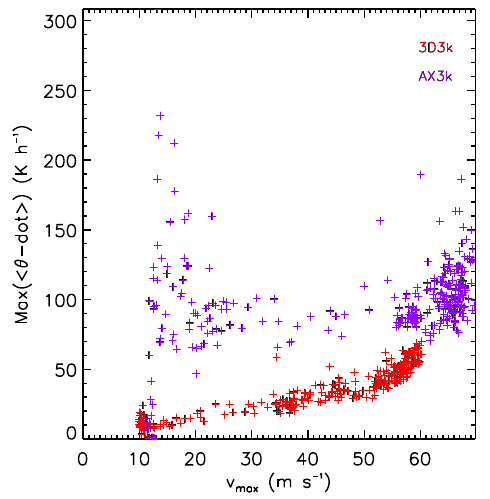
Fig. 6. Time series of maximum azimuthally averaged (mean) heat- Fig. 6. Time-series of maximum azimuthally-averaged (mean) heat- ing rates in the 3D3k simulation (red solid curve) and the corre- ing rates in the 3D3k simulation (red solid curve) and the corre- sponding heating rate in the AX3k simulation (green solid curve). sponding heating rate in the AX3k simulation (green solid curve). The extreme value of the heating rate found at each time in the 3D3k The extreme value of the heating rate found at each time in the 3D3k simulation is shown by the blue-dotted curve. simulation is shown by the blue-dotted curve.